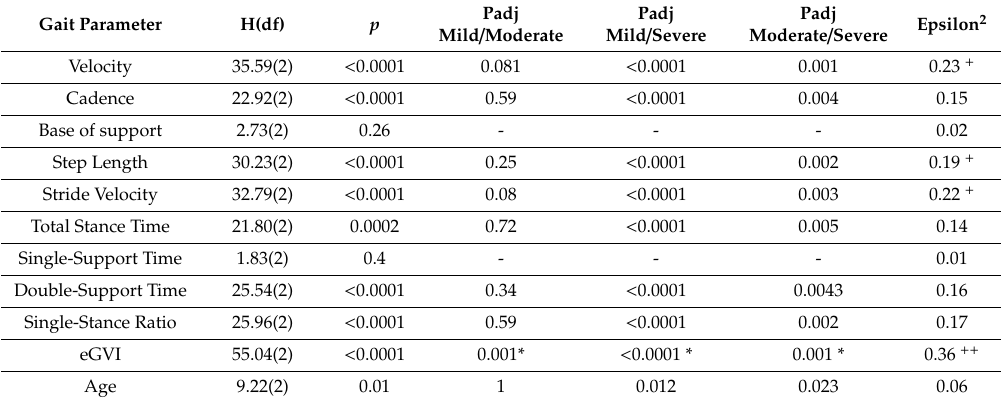
Table 5. Kruskal–Wallis H-test, Bonferroni-adjusted p , and Epsilon squared e ff ect sizes.